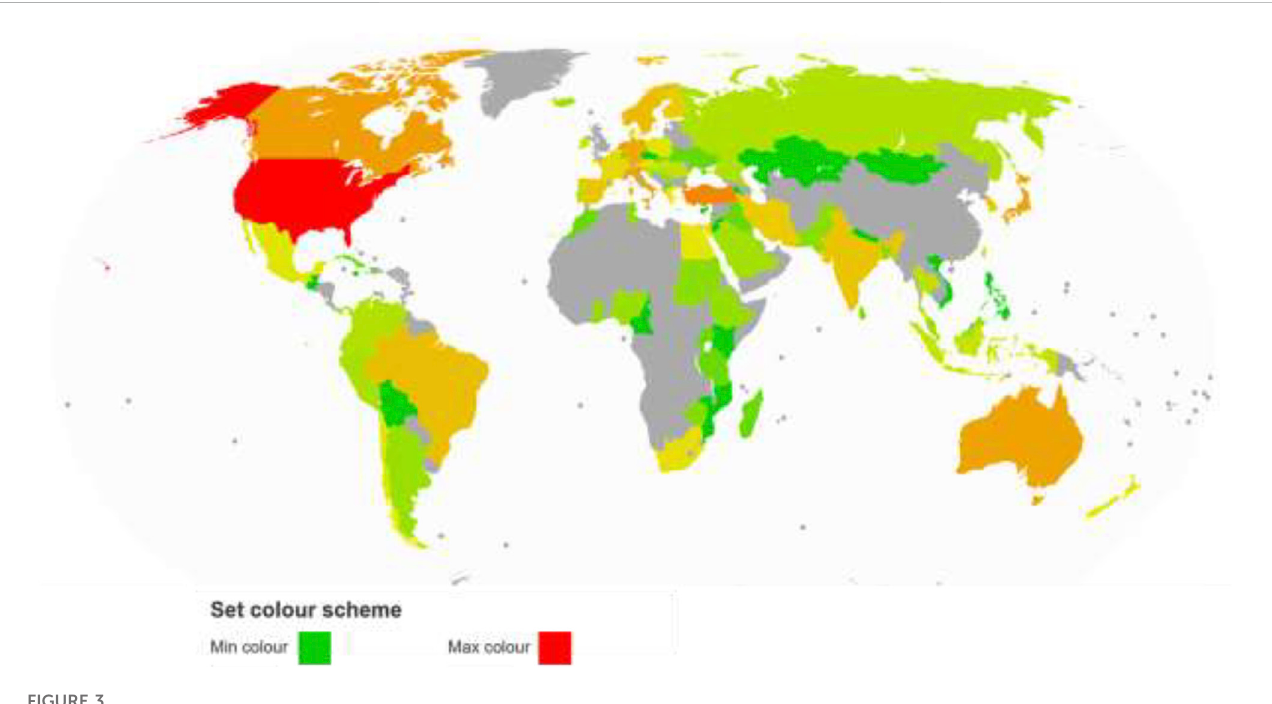
FIGURE 3 Regions map based on